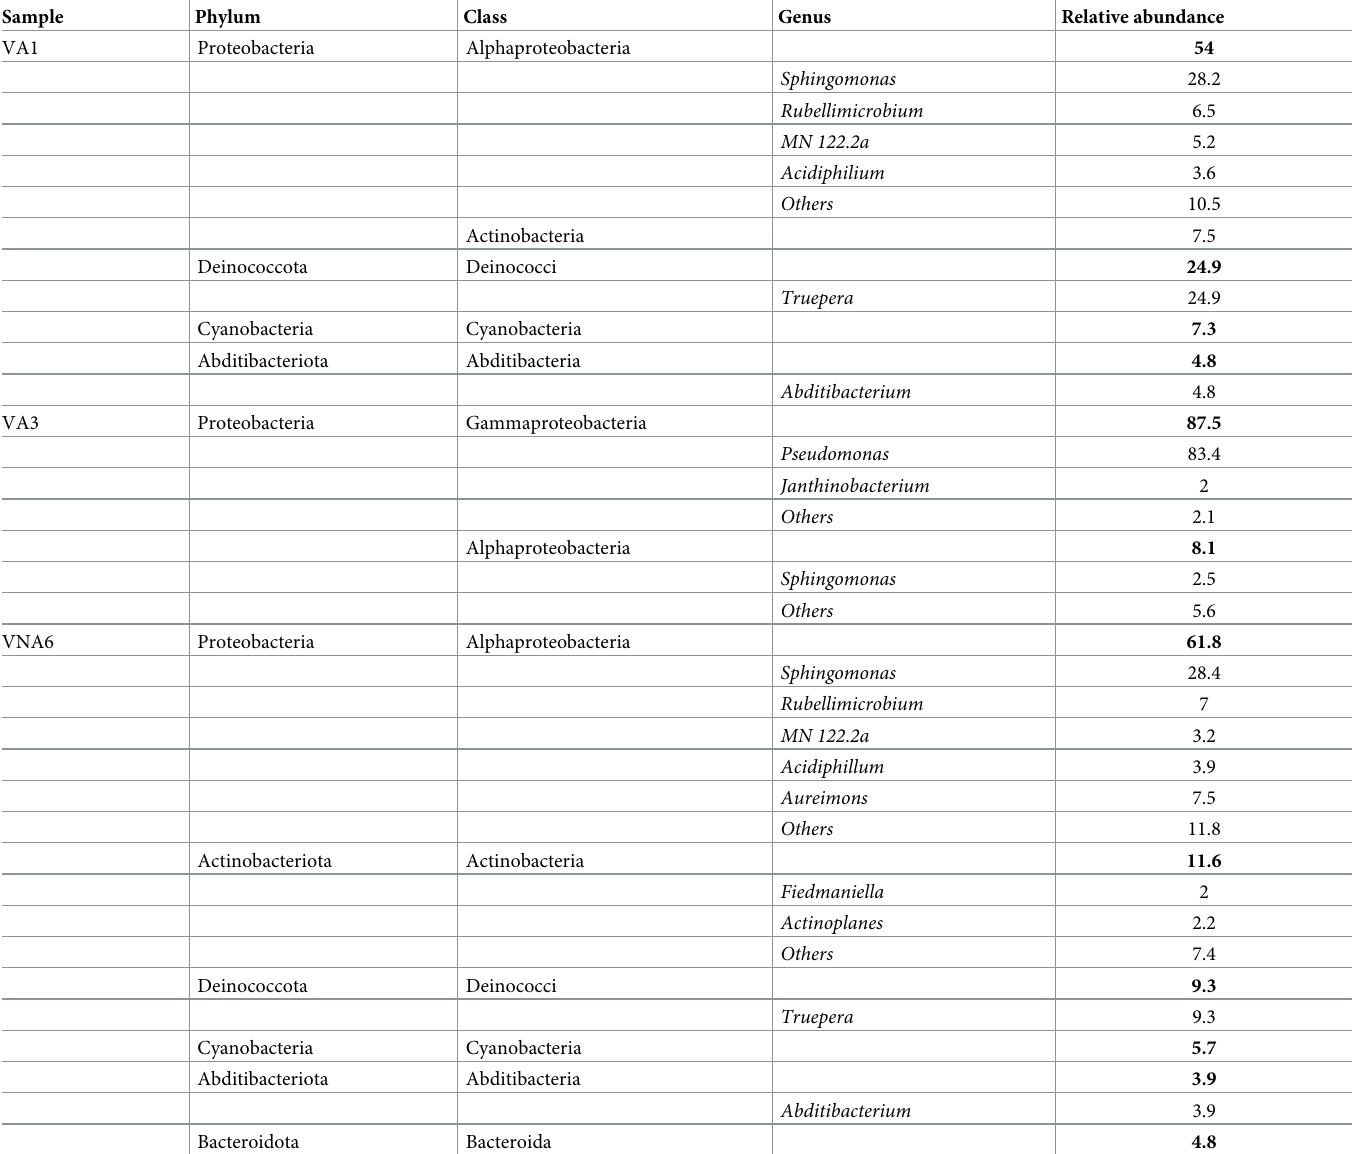
Table 3. Percent of bacteria genus identify for each sample. ‘Others’ corresponds to non-identified